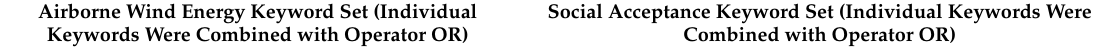
Table A1. Keywords selected for the literature search in Google